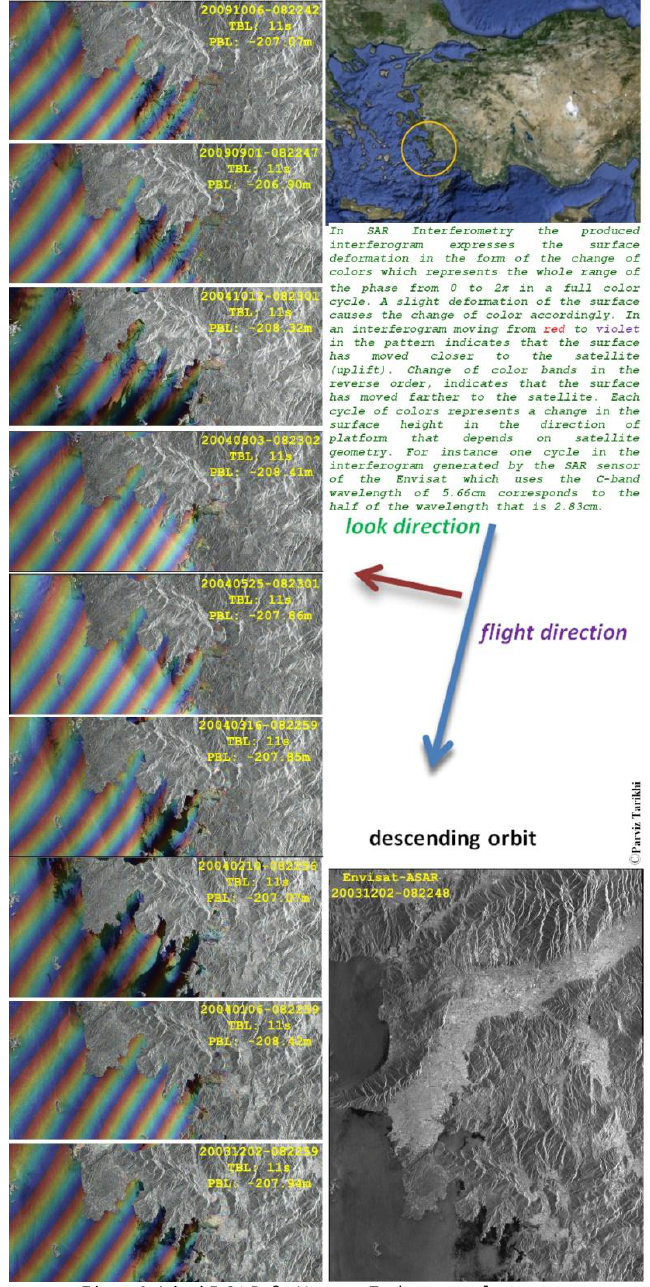
Figure 9: Liqui-InSAR for Western Turkey coastal zones